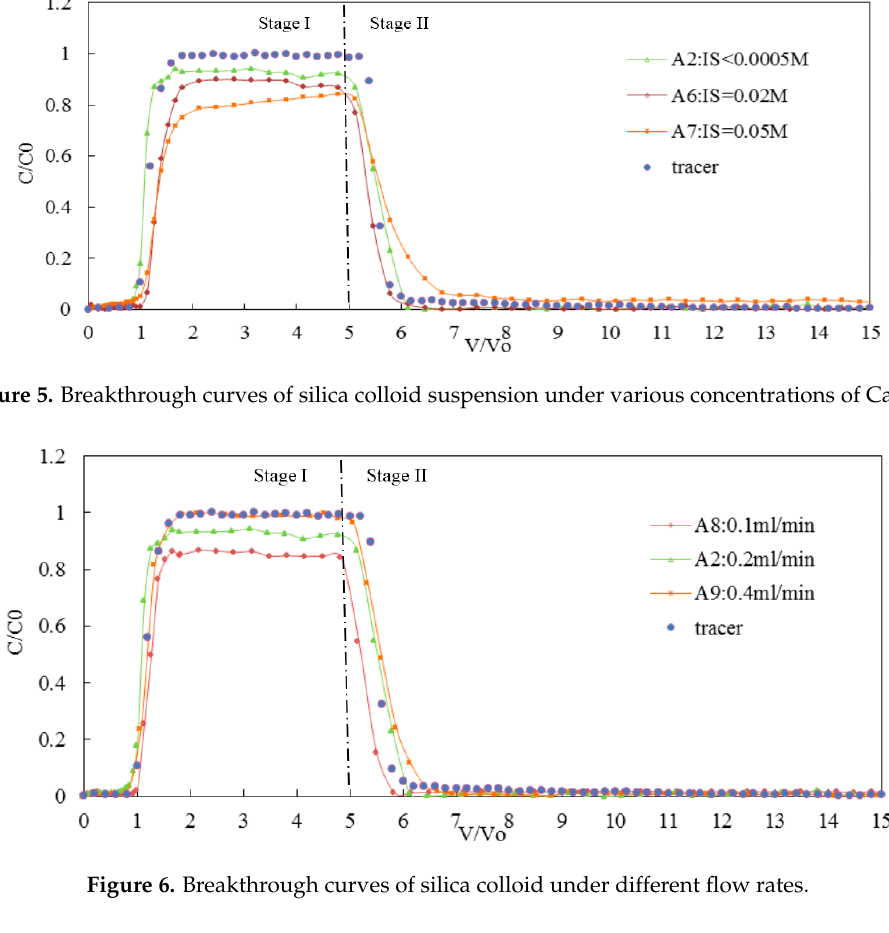
Figure 6. Breakthrough curves of silica colloid under different flow rates.